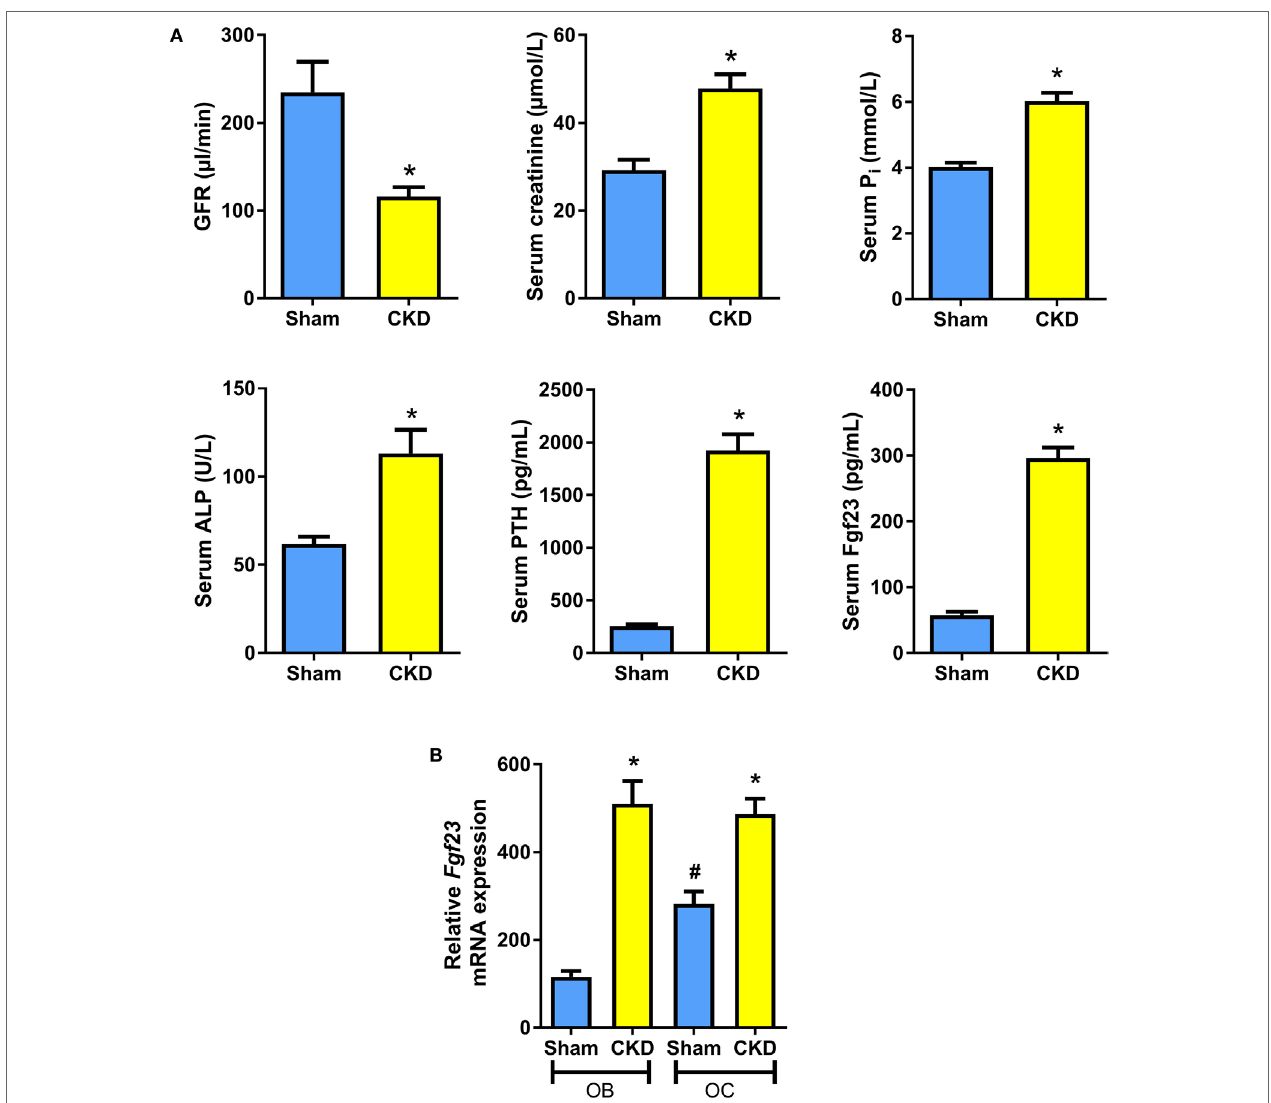
FigUre 1 | 5/6-nephrectomy induces chronic kidney disease (CKD) and increased osteoblastic and osteocytic Fgf23 mRNA expression in mice on high phosphate diet. (a) Glomerular filtration rate (GFR) ( n = 12–13 each), serum creatinine ( n = 12 each), serum phosphate ( n = 12 each), serum alkaline phosphatase (ALP) activity (14 Sham, 20 CKD), serum parathyroid hormone (PTH) ( n = 12 each), and serum intact Fgf23 ( n = 5 each) in 5-month-old male C57BL/6 Sham and CKD mice on the phosphate-rich rescue diet, 8 weeks postsurgery. * P < 0.05 vs. Sham by t -test or Mann–Whitney U -test as appropriate. (B) In situ mRNA expression profiling of osteoblasts (OB) and osteocytes (OC) harvested by laser capture microdissection in 4- μ m-thick distal femoral cryosections from 5-month-old male C57BL/6 Sham ( n = 7–8) and CKD ( n = 2) mice on rescue diet, 8 weeks postsurgery. * P < 0.05 vs. Sham, # P < 0.05 vs. Sham OB by one-way analysis of variance followed by Holm–Sidak’s multiple comparisons test. Data in (a,B) are mean ±